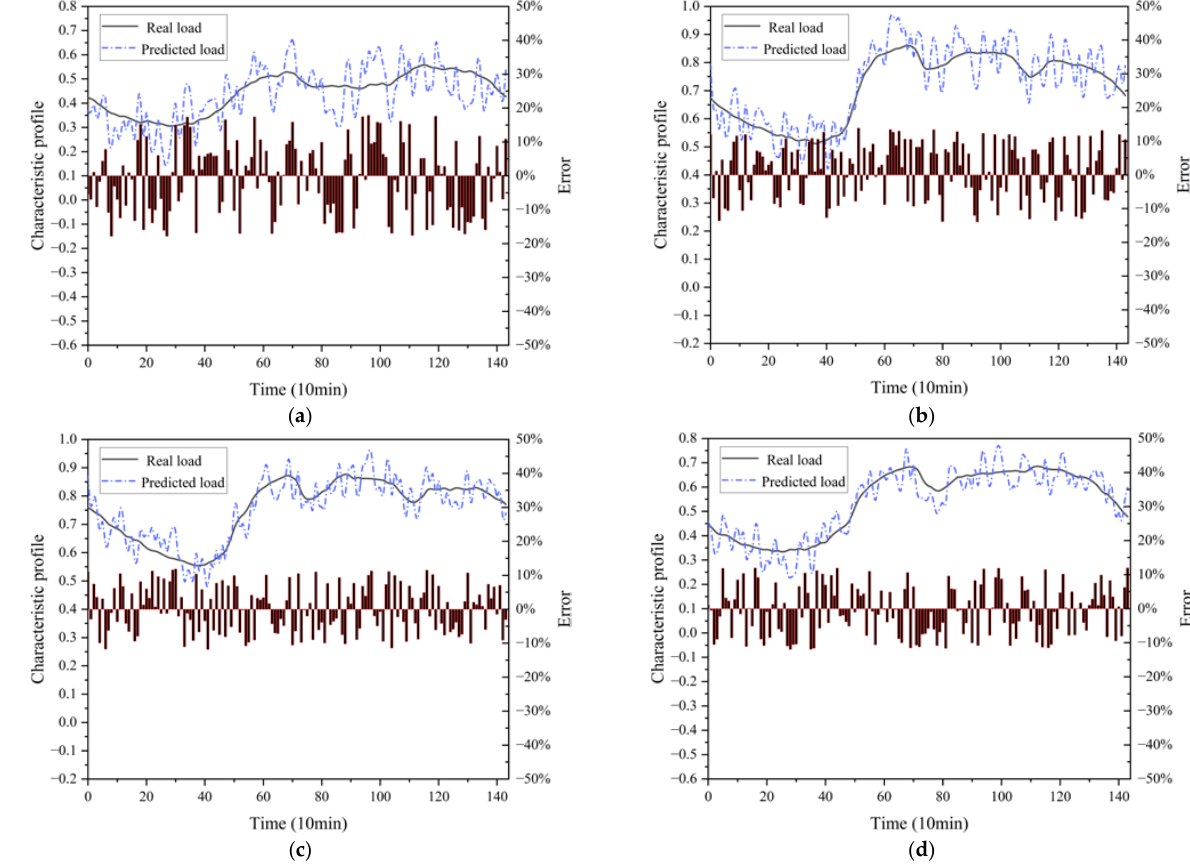
Figure 8. The prediction results and deviations of the load on four typical days. ( a ) Spring; ( b ) Summer; ( c ) Autumn; ( d ) Winter.